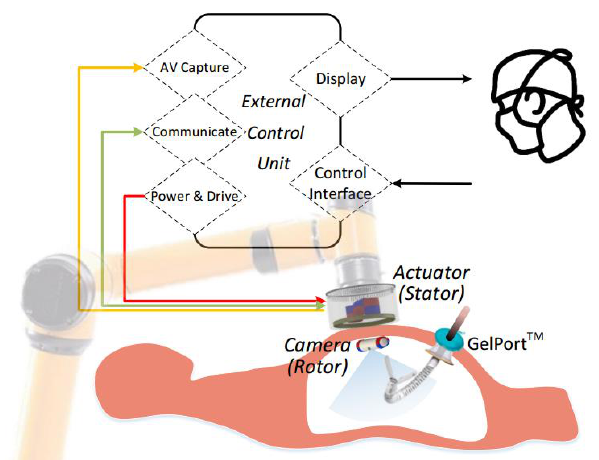
Figure 2. s-CAM concept and working principle. An AUBO-i5™ [32] collaborative robotic arm (Smokie Robotics, Inc., Knoxville, TN, USA), a continuum robotic manipulator (Titan Medical Inc., Toronto, ON, Canada) and a GelPort ® SILS access port (Applied Medical Resources Corporation, Rancho Santa Margarita, CA, USA) are included for technical